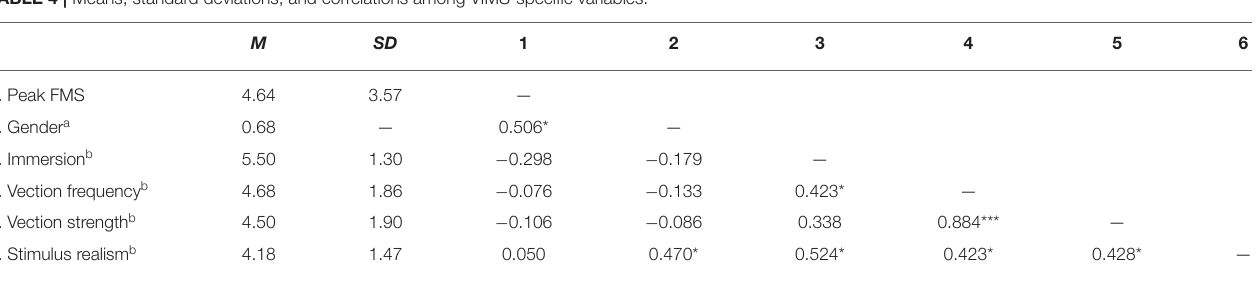
TABLE 4 | Means, standard deviations, and correlations among VIMS-specific